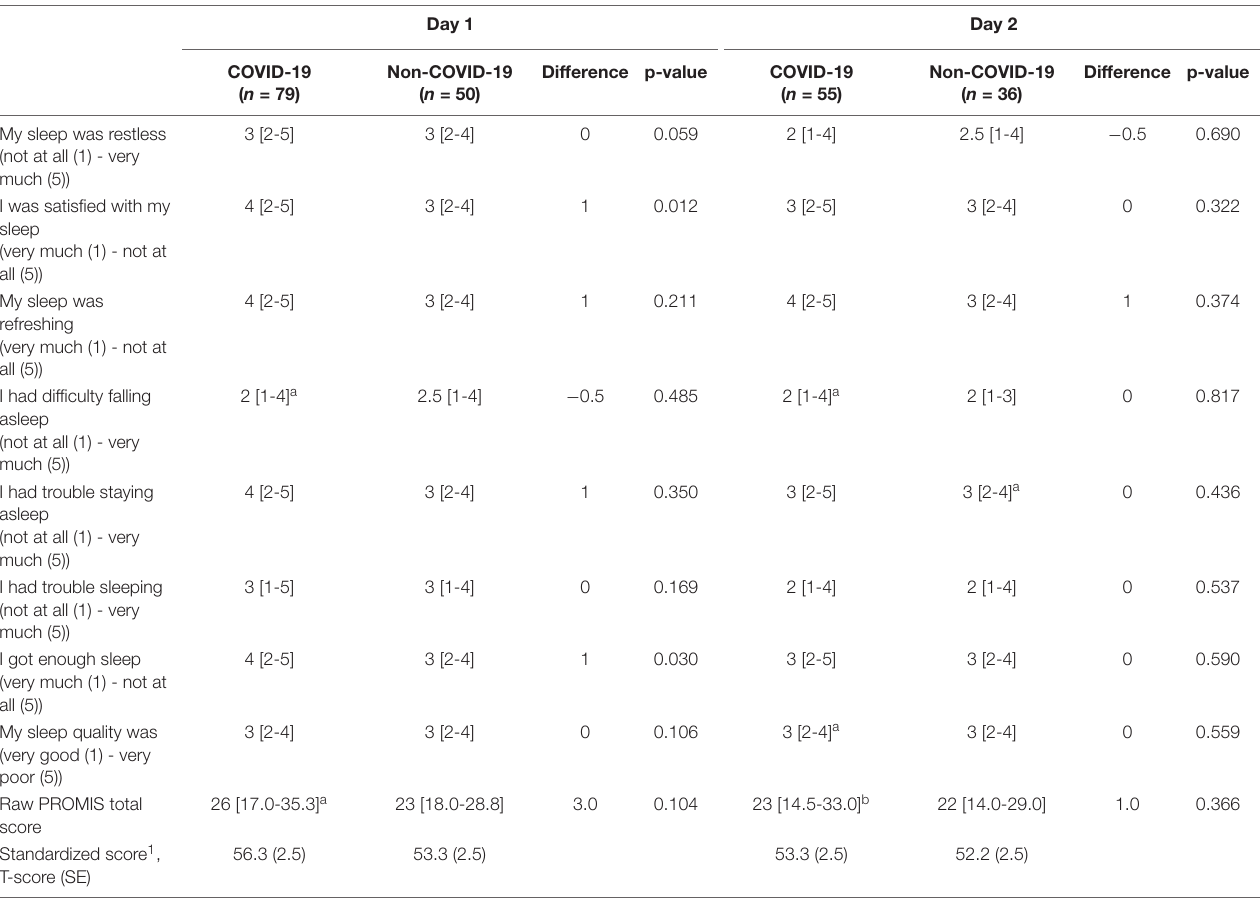
TABLE 3 | Sleep quality measured by means of PROMIS Sleep Disturbance